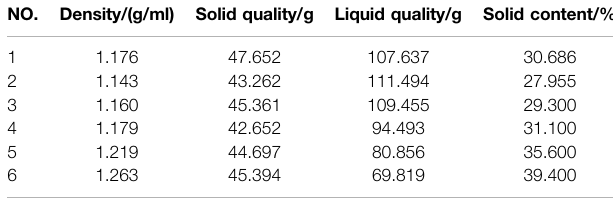
TABLE 3 | The test data of density and solid content of wet-based carbide slag.